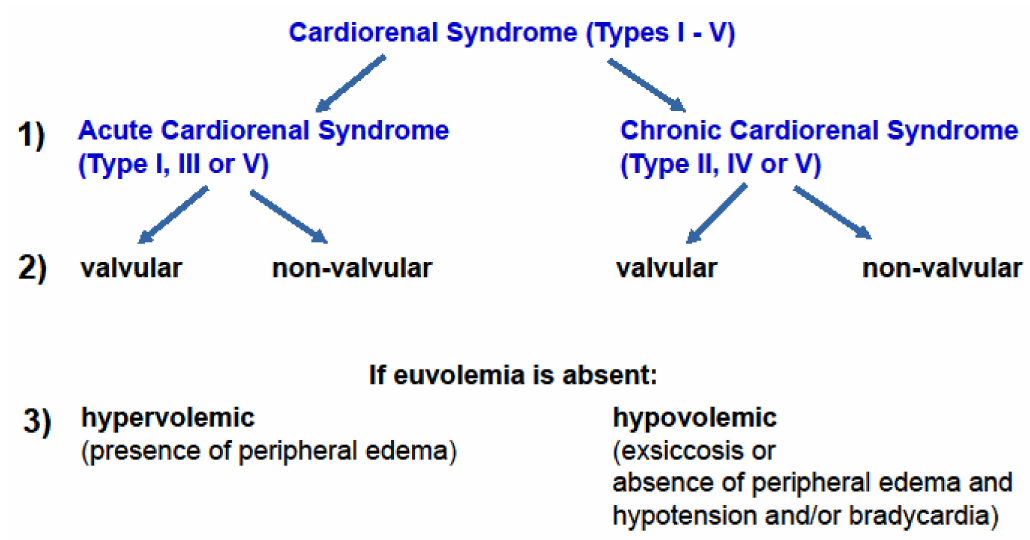
Figure 3. Title: A proposed new classification of cardiorenal syndrome. Legend: An upgraded classification of CRS requires clinical information that further specifies current consensus classification of CRS [1]. Aside from etiology and time course of CRS, clinical hallmarks such as the volemic state are